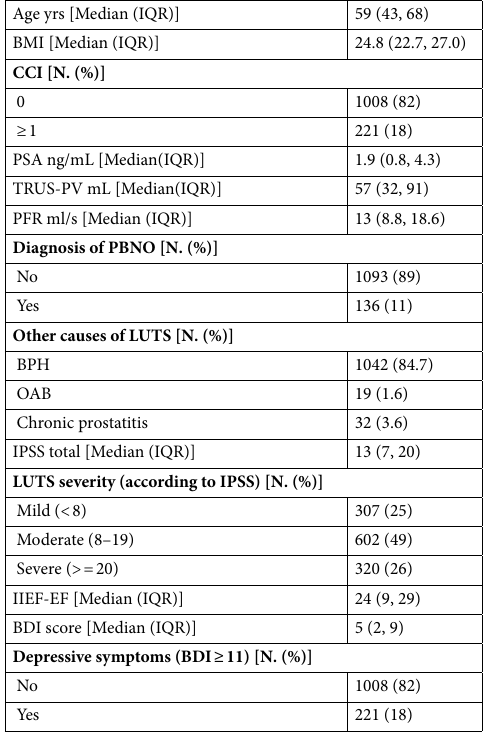
Table 1. Descriptive characteristics of the entire cohort (N. = 1229). Keys: BMI = body mass index; CCI = Charlson comorbidity index; PSA = prostate-specific antigen; TRUS = trans-rectal ultrasound; PV = prostate volume; PFR = peak flow rate; PBNO = primary bladder neck obstruction; LUTS = lower urinary tract symptoms; BPH = benign prostatic hyperplasia; OAB = overactive bladder; IPSS = International Prostate Symptoms Score; IIEF-EF: International Index of Erectile Function-erectile function domain; BDI = Beck’s Inventory for